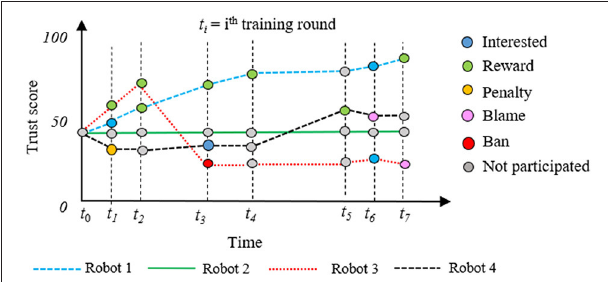
FIGURE 5 | Activity dependent trust score update of four distributed mobile